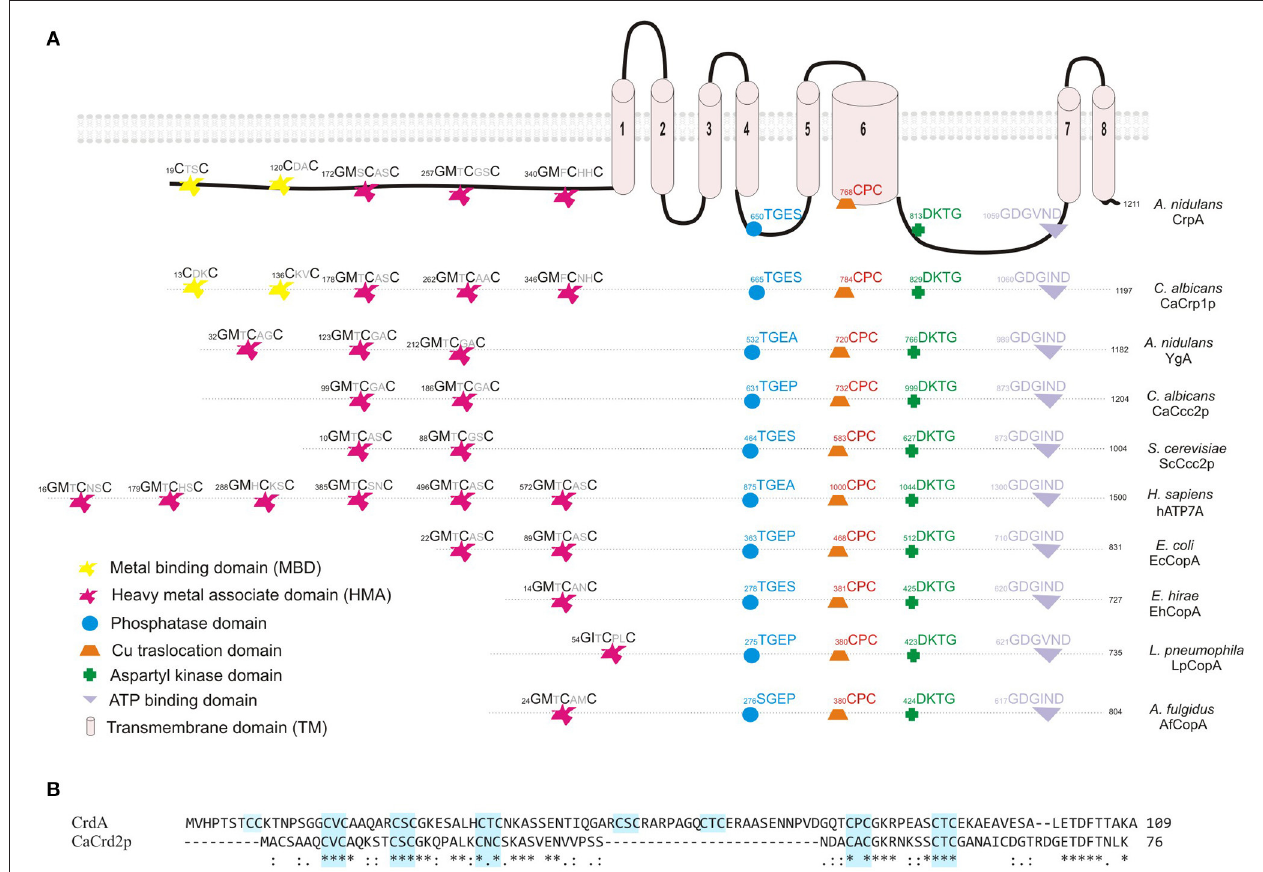
FIGURE 1 | Sequence analysis of CrpA and CrdA. (A) Proposed two dimensional model of CrpA describing the predicted membrane topology and comparison of the conserved functional domains of P I -type ATPases and their position among different species. GenBank accession numbers are given in parentheses: Aspergillus nidulans CrpA (CBF83376.1) and YgA (CBF75750.1); Candida albicans CaCrp1p (AAF78958.1) and CaCcc2p (XP_720761.1); Saccharomyces cerevisieae ScCcc2p (AAC37425.1); Homo sapiens Menkes disease protein hATP7A (AAA35580.1); Escherichia coli EcCopA (CDL39203.1); Enterococcus hirae EhCopA (AAA61835.1); Legionella pneumophila copper-translocating P -type ATPase (WP_010947353.1); Archaeoglobus fulgidus copper-exporting P -type ATPase AfCopA (KUJ93751.1). (B) Alignment of predicted full-length of CrdA and CaCrd2p sequences compared using Clustal method. Asterisks describe identical, double and single dots , conservative and semi-conservative residues, respectively. CxC repeats are boxed in light blue. Protein accession numbers are reported as follows: Aspergillus nidulans CrdA (CBF79264.1) and Candida albicans CaCrd2p